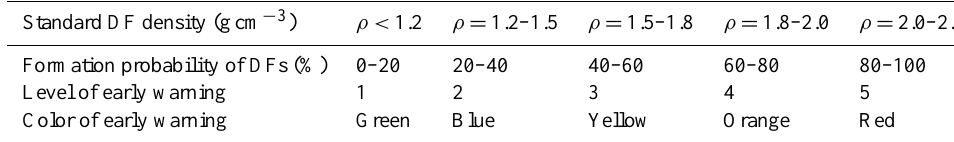
Table 1. Formation probability of DFs according to the water–soil mixture density.